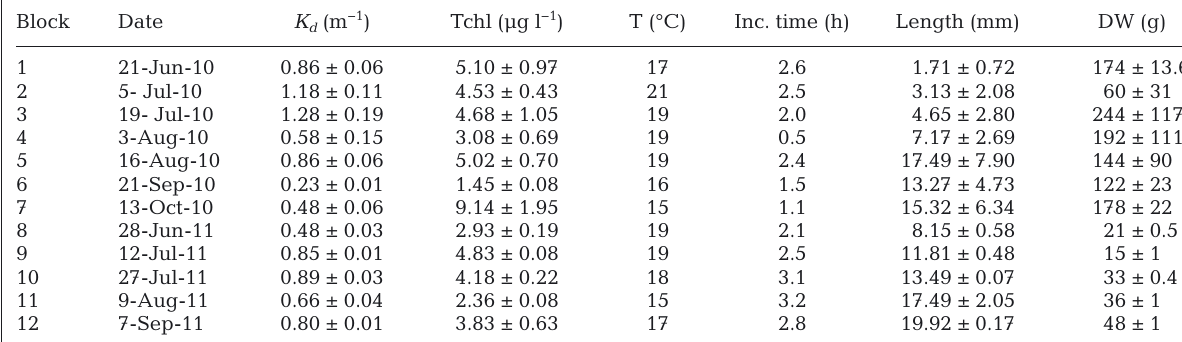
took place every other day. In 2011, bacteria were sampled in addition to all other parameters. Ciliates were sampled for all 12 blocks, but not all samples were analysed due to lack of time and money. The total volume sampled per block was always less than 10% of the original volume. At the end of the 8 to 9 d and stored for the next occasion.